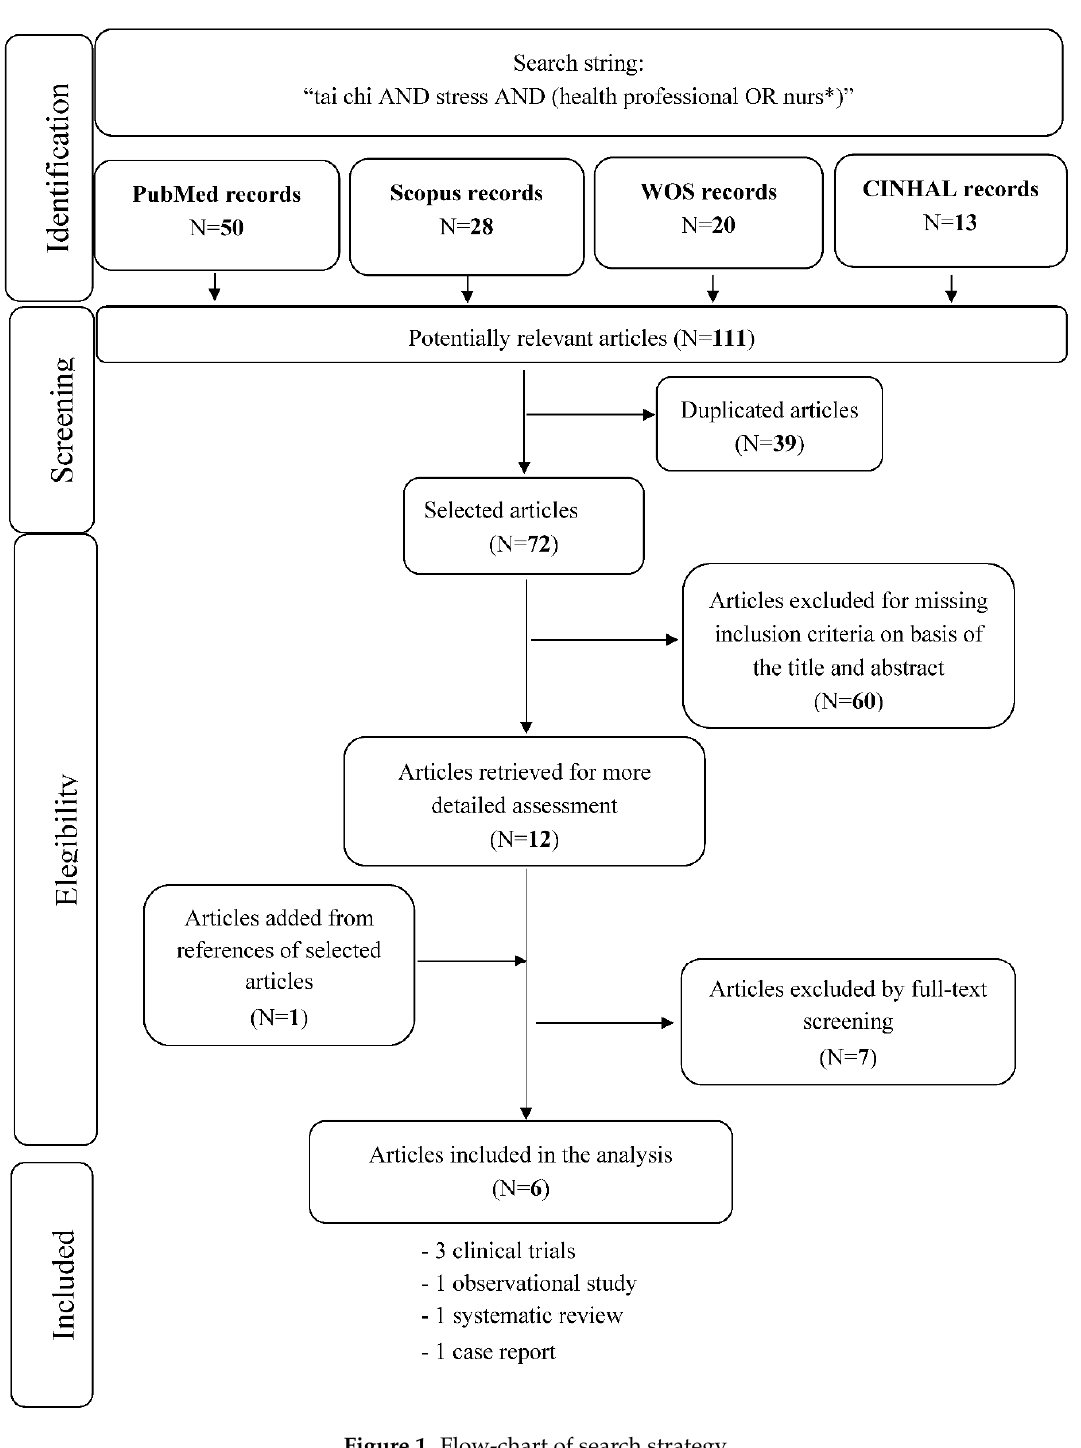
Figure 1. Flow-chart of search strategy.